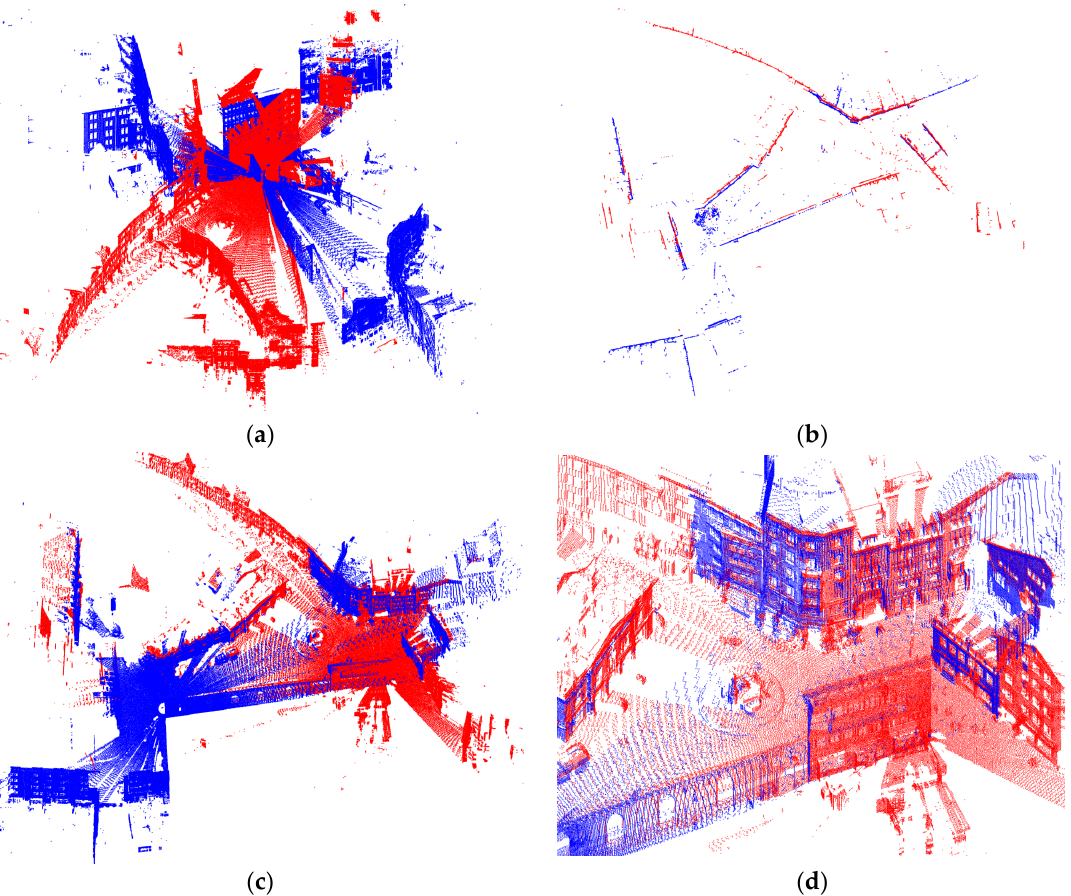
Figure 6. The coarse registration result of City. (a) The source and target point clouds. (b) The registration result of the simplified 2D point clouds. (c) The registration result of the 3D point clouds. (d) The locally amplified point clouds for a better view.